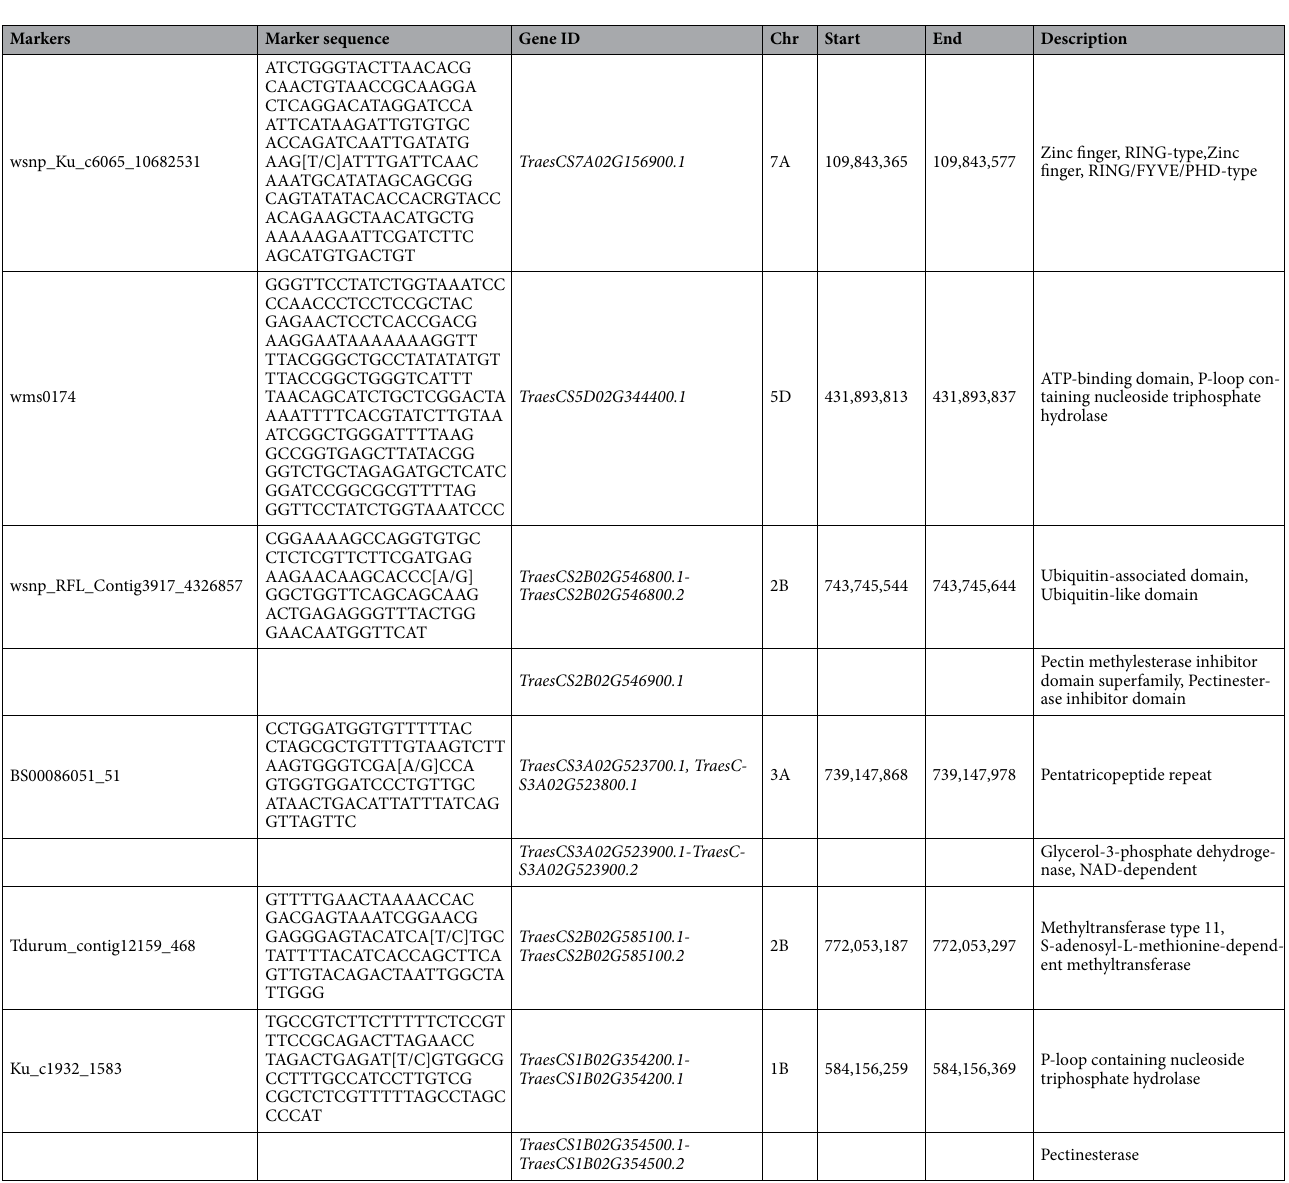
Table 3. Details of disease related candidate gene showing putative associations with Heterodera avenae resistance in wheat. Chr: